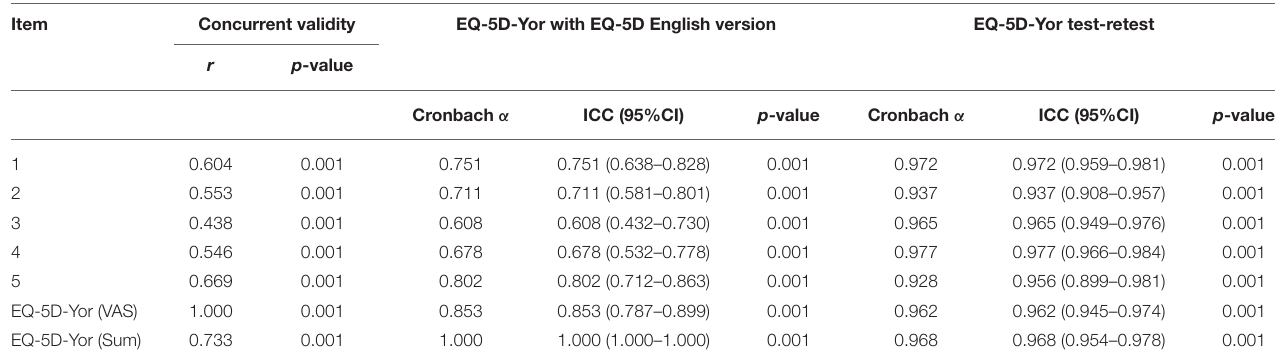
TABLE 3 | Concurrent validity, Cronbach’s alpha, internal consistency of the EQ-5D-Yor